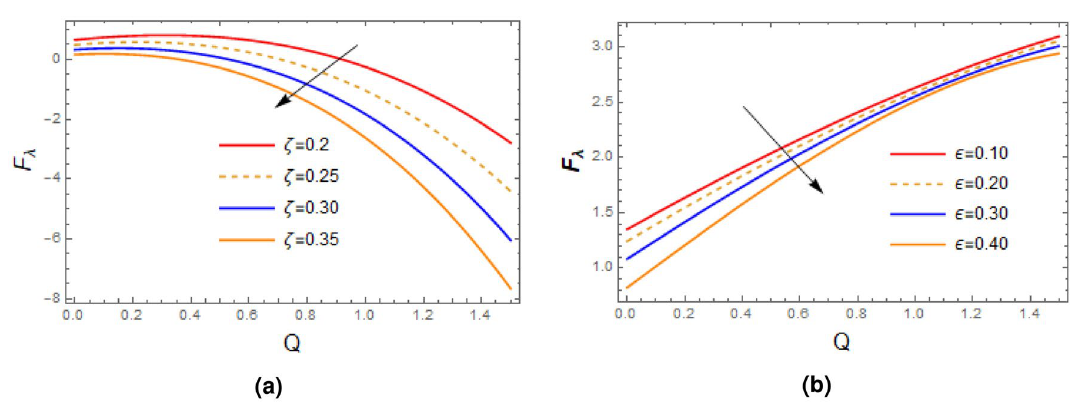
Figure 11. Plots of frictional force on wall of tubules, variations of ζ and ε are exhibited with α = 1, δ = 0.2, Q = 0.5 ( a ) ε = 0.2 , ( b ) ζ = 0.02